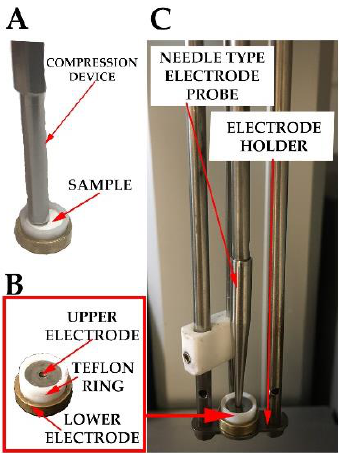
Figure 1. Photos of the TSCII setup (( A ) measured and compressed sample; ( B ) measuring cell containing the sample; ( C ) measuring cell inserted into the TSCII device).